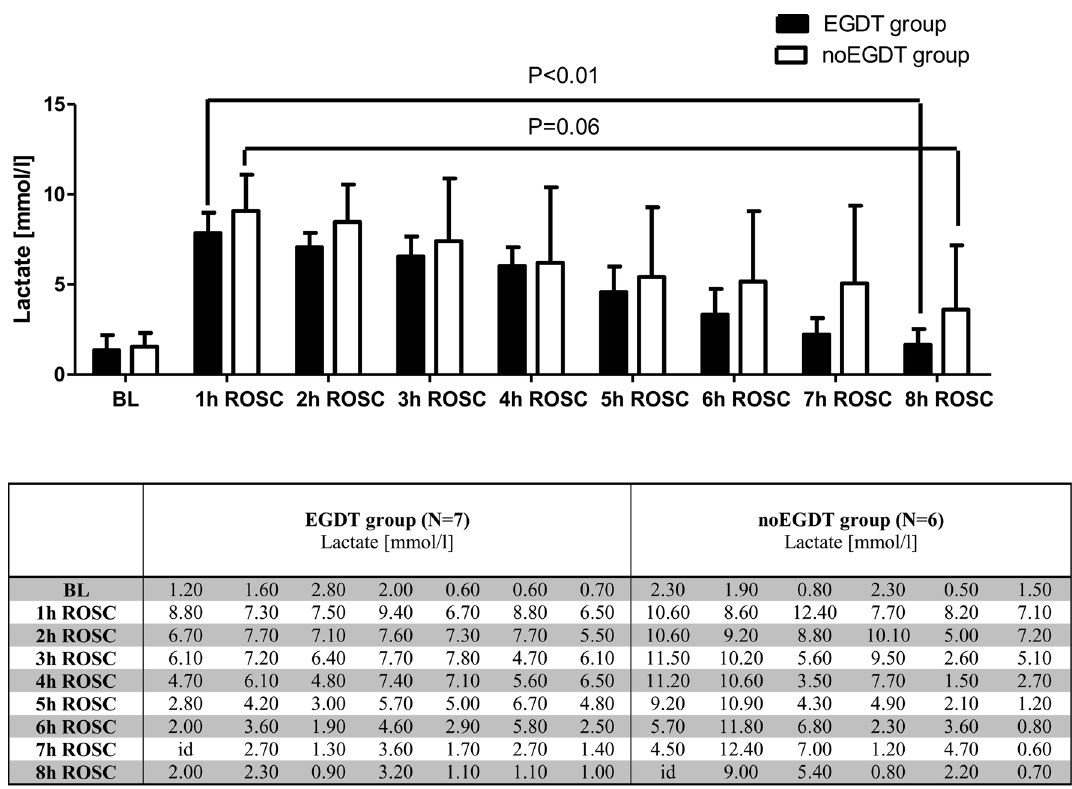
Figure 6. Mean concentrations of plasma lactate at baseline and between 1 h and 8 h after ROSC in the EGDT and noEGDT group (upper panel). Columns show the mean, bars denote SD. Lactate values for each animal are depicted in the table (lower panel). id invalid